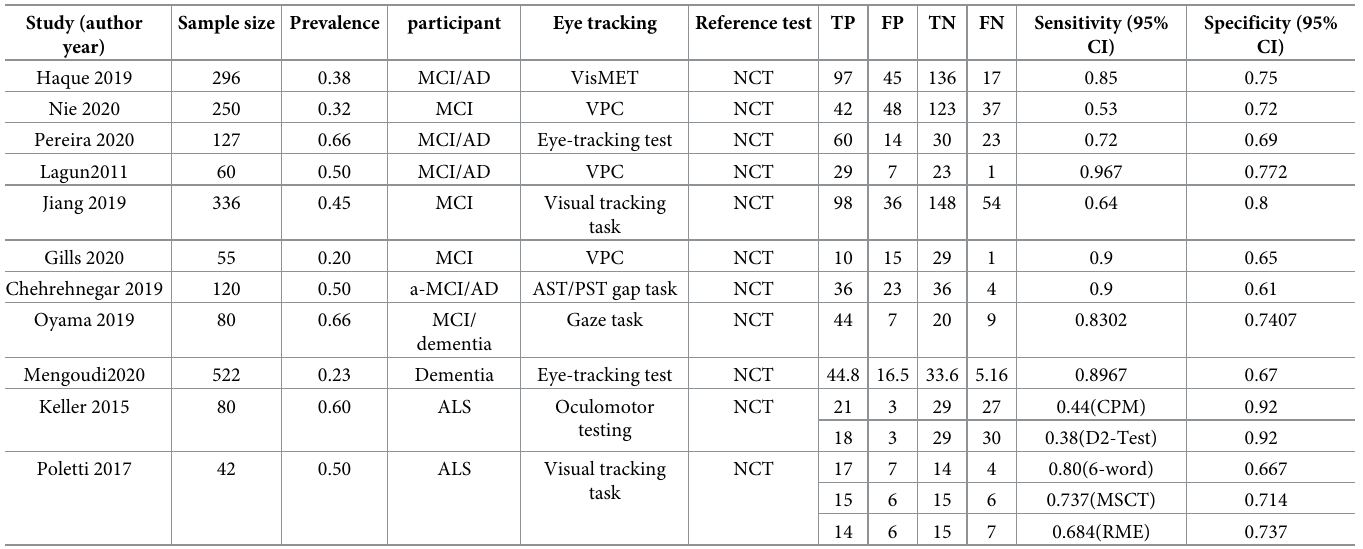
Table 1. The characteristics of the included studies.